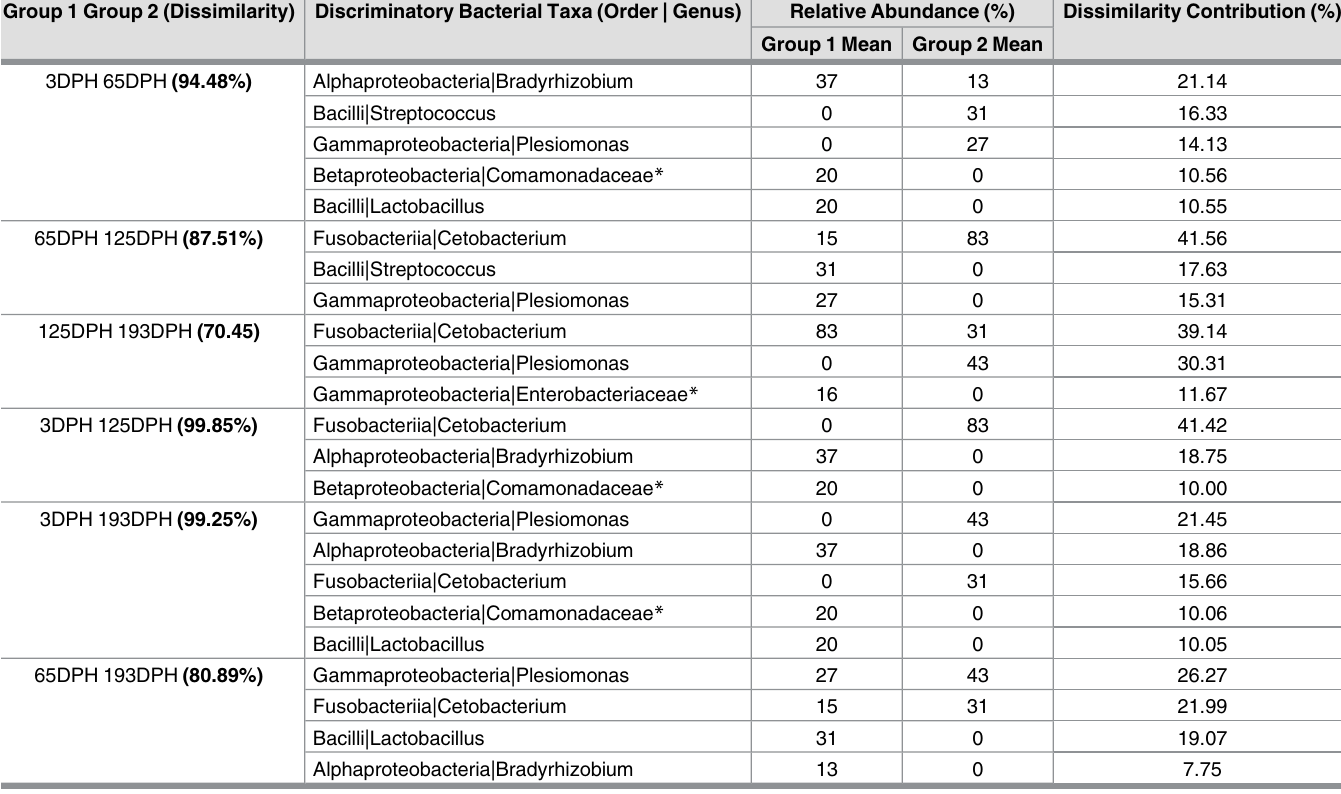
Table 3. Similarity percentage analysis (SIMPER) of the most discriminatory bacterial taxa detected in the intestine of channel catfish sampled at various ages (days post hatch; DPH). Prior to the analysis, OTUs were filtered to remove those detected in less than three individual samples. Only those OTUs which accountedfor the top 70% of betweengroup dissimilarity are